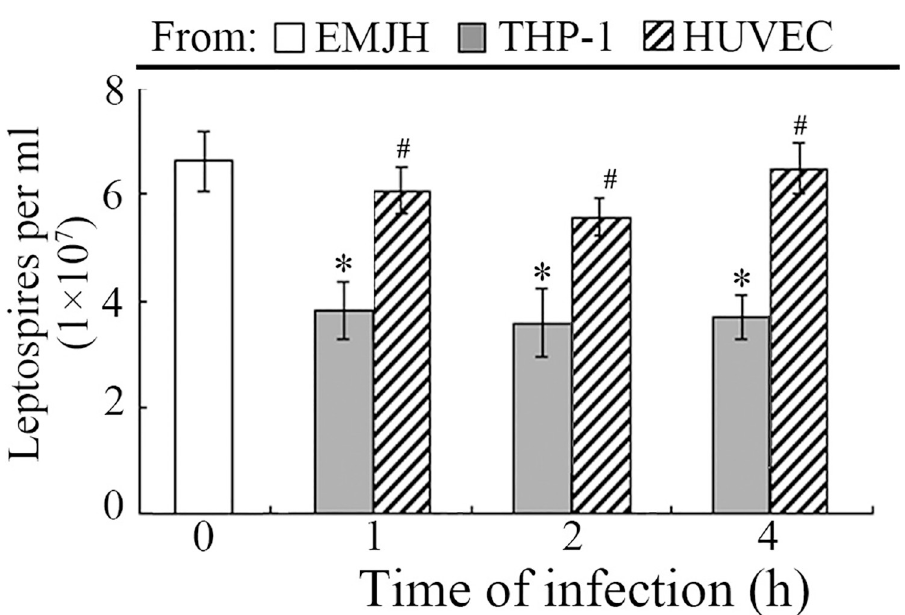
Fig 2. Various viability of Leptospira in THP-1 and HUVEC. Viability of L . interrogans strain Lai in the infected THP-1 and HUVEC for the indicated times. There is no significant difference between the numbers of leptospires in the cultures from specimens of the infected HUVEC and from EMJH medium. � : p < 0.05 vs the number of leptospires in the cultures from specimens of the EMJH medium. #: p < 0.05 vs the number of leptospires in the cultures from specimens of the infected THP-1